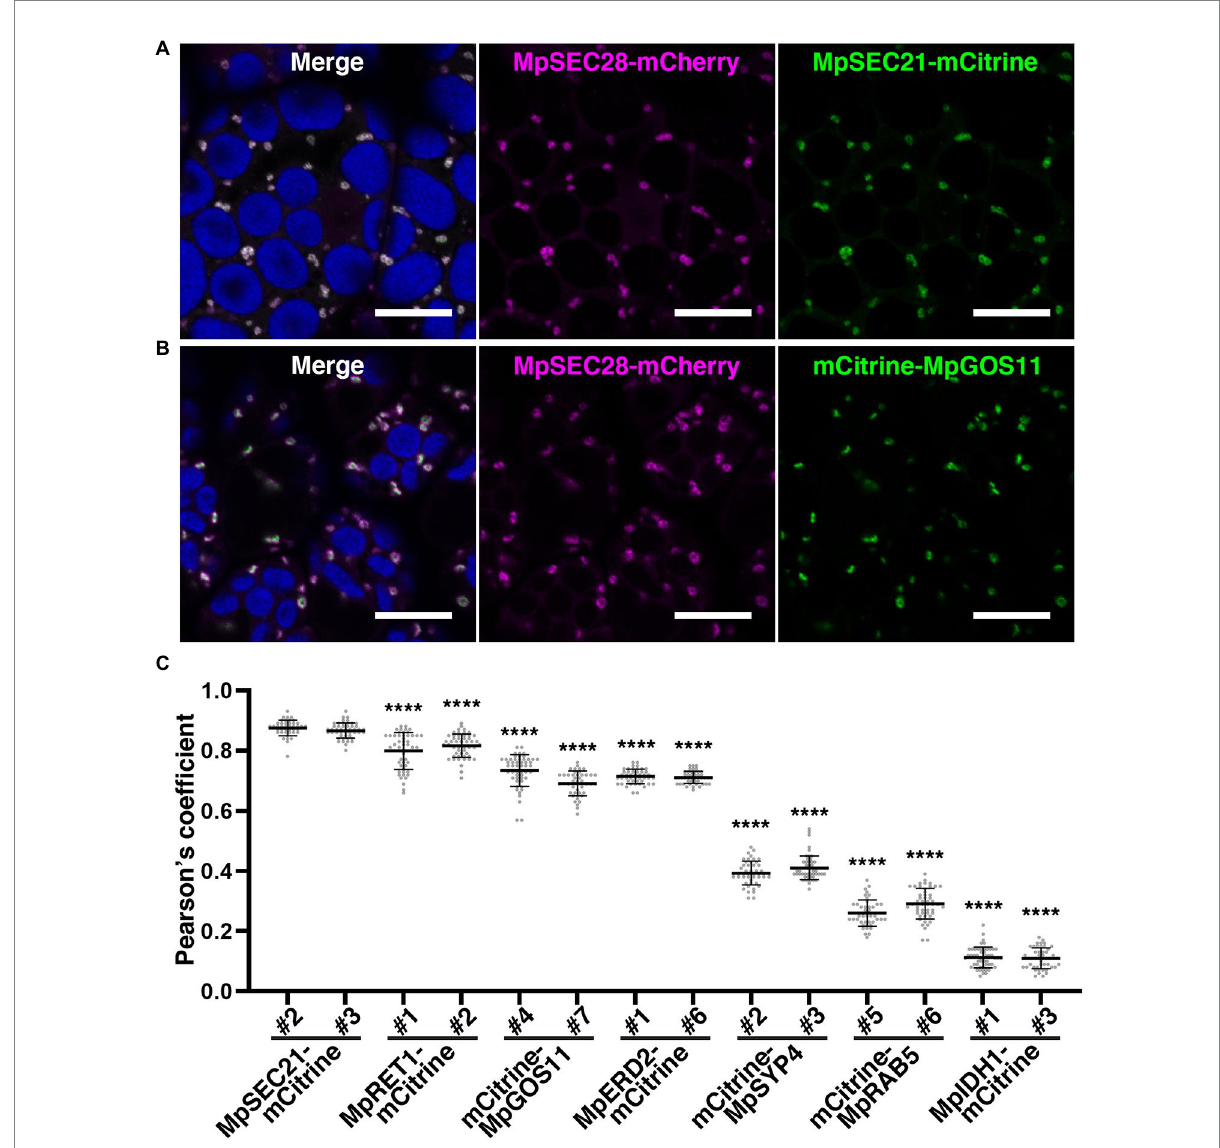
FIGURE 4 MpSEC28-mCherry colocalization with COPI components. (A–B) Single confocal images of M . polymorpha thallus cells expressing MpSEC28- mCherry and MpSEC21-mCitrine (A) or mCitrine-MpGOS11 (B) . Magenta, green, and blue pseudo-colors indicate fluorescence from mCherry, mCitrine, and chlorophyll, respectively. Bars = 10 μ m. (C) Pearson correlation coefficients between the fluorescence from MpSEC28-mCherry and organelle markers. Data are presented as the means ± s.d. Significant differences between MpSEC21-mCitrine #2 and each organelle marker were statistically analyzed using a two-tailed Welch’s t -test. **** p < 0.001. n = 50 and 51, and p = 2.33 × 10 − 11 and 2.25 × 10 − 13 for MpRET1-mCitrine#1 and #2, respectively. n = 52 and 44 and p = 6.71 × 10 − 28 and 6.80 × 10 − 38 for mCitrine-MpGOS11#4 and #7, respectively. n = 47 and 46 and p = 6.52 × 10 − 47 and 3.74 × 10 − 47 for MpERD2-mCitrine#1 and #6, respectively. n = 48 and 56 and p = 2.60 × 10 − 74 and 3.96 × 10 − 83 for mCitrine-MpSYP4#2 and #3, respectively. n = 45 and 50 and p = 7.07 × 10 − 73 and 5.64 × 10 − 71 for mCitrine-MpRAB5#5 and #6, respectively. n = 51 and 46 and p = 8.70 × 10 − 102